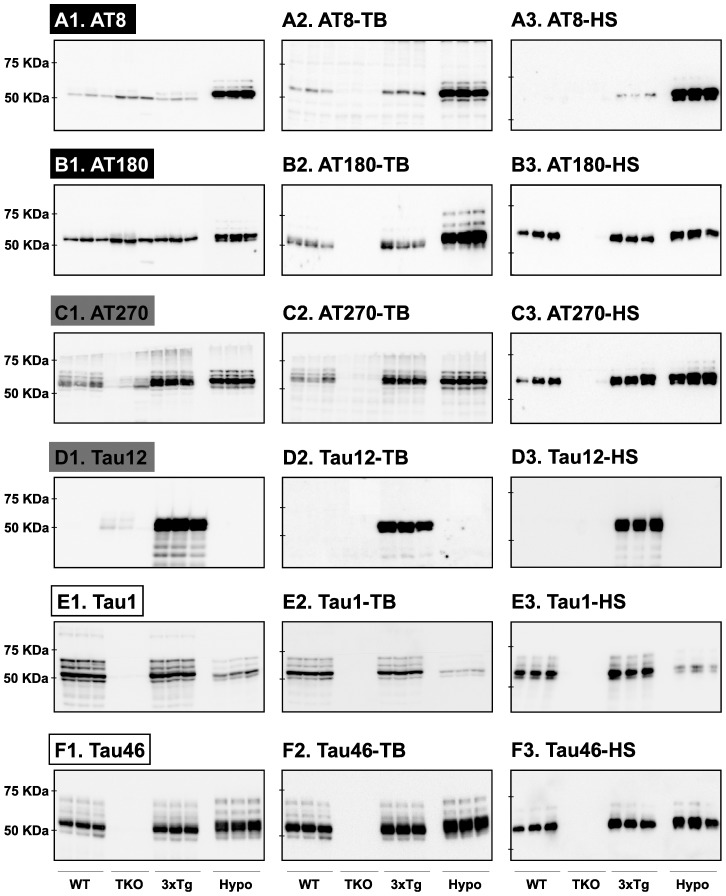
Analysis of tau signal with commercial monoclonal antibodies by Western blotting.The proteins were extracted form the cortex of 3 mouse lines: control mice (WT and Hypothermic), Tau KO mice and 3xTg mice with n = 3 for each group. Proteins were extracted with SDS-PAGE and then identified with the following commercial monoclonal antibodies: A: AT8, B: AT180, C: AT270, D: Tau 12, E: Tau1 and F: Tau 46. Normal anti-mouse (1) and Mouse TrueBlot ULTRA (2) secondary antibodies were used to detect primary antibodies. The heat stable fraction was used to remove non-specificity (3). Quantifications of the blots are available in Figure S1.